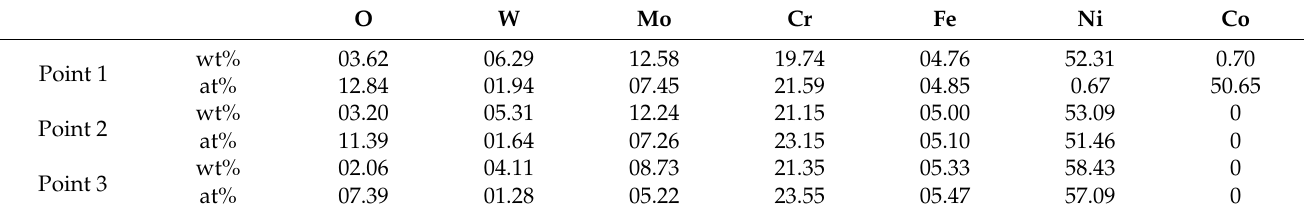
Figure 14. SEM morphology of the C22 coating after potentiostatic polarization at 600 mV mse 70 ◦ C. Table 4. EDS analysis results of the C22